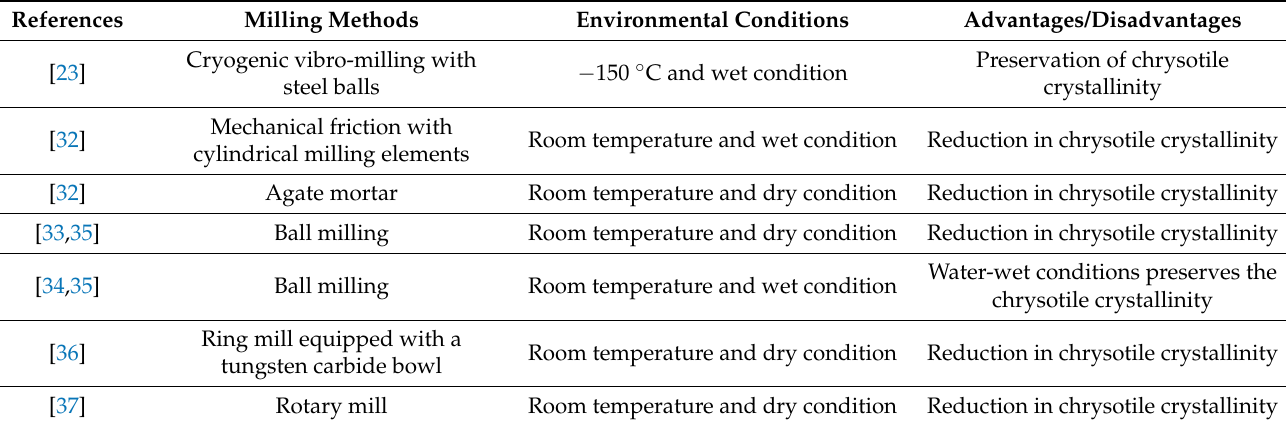
Table 1. Comparison of different methods used for milling